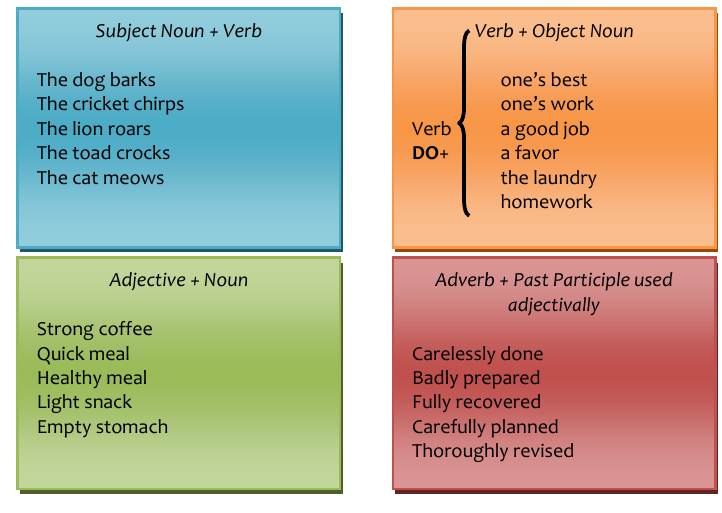
Figure 1. Basic Types of